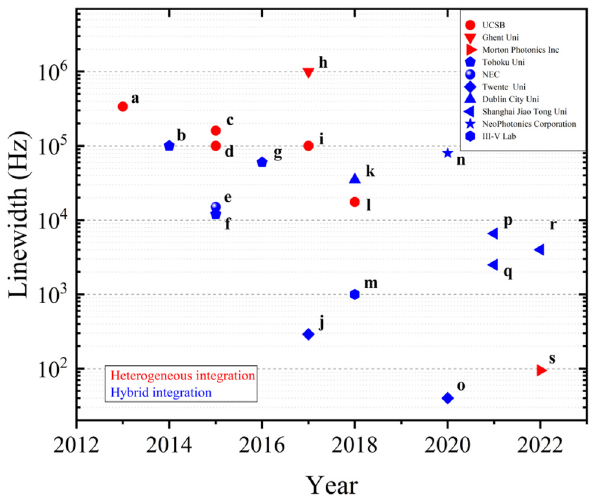
Figure 11: Progress of silicon-based tunable laser linewidth performance. a [87], b [72], c [89], d [88], e [71], f [74], g [75], h [97], i [91], j [80], k [115], l [92], m [104], n [116], o [81], p [83], q [82], r [105], s [95]. (The different colors represent the different integration methods. The red color represents the heterogeneous integration and the blue color represents the hybrid